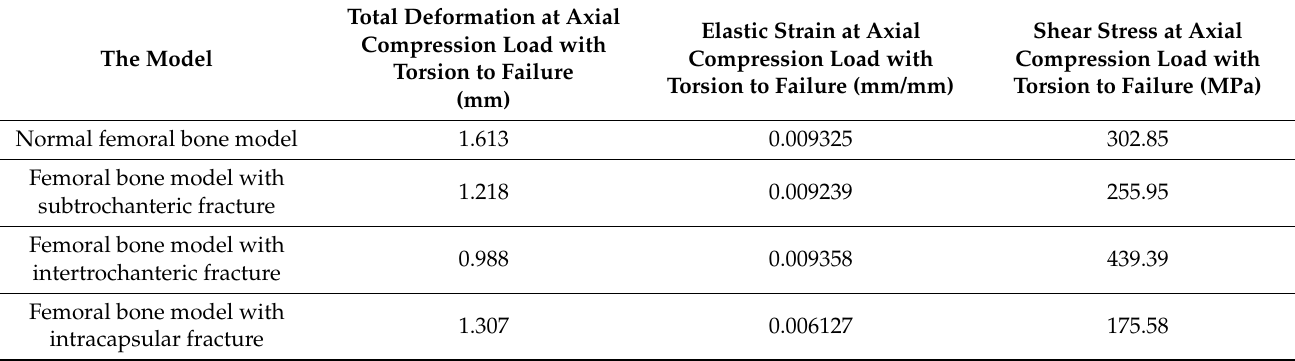
Table 12. Max deformation, strain, and shear in axial compression load with torsion to failure scenario.